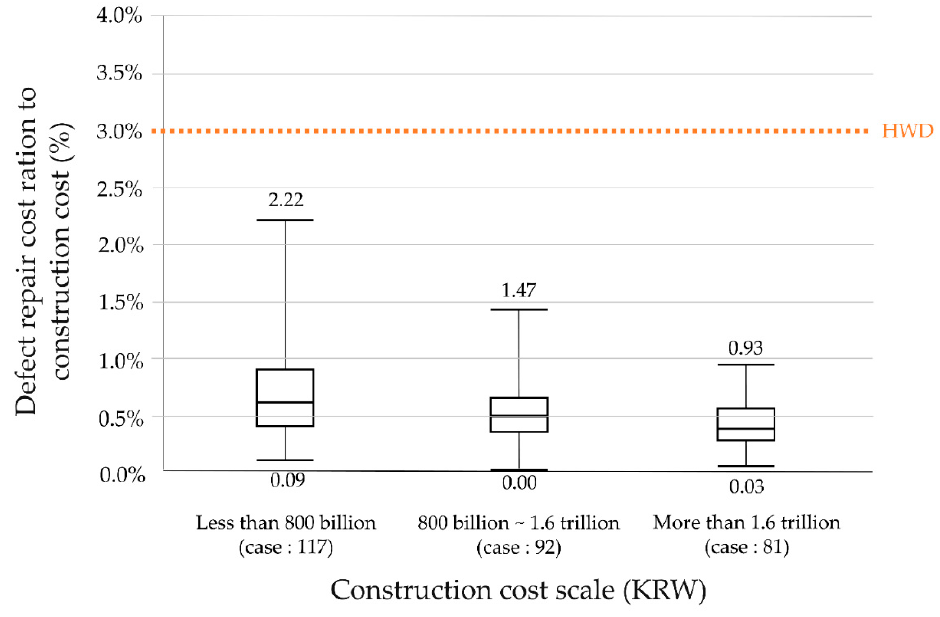
Figure 4. Comparison of the construction cost scale.